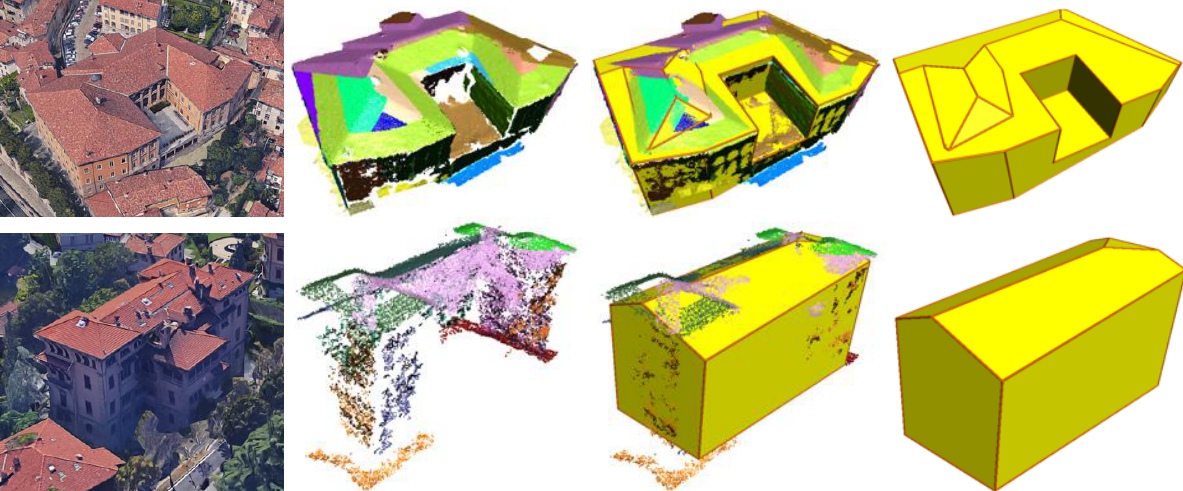
Figure 13. Examples of 3D reconstructions of different buildings from the Bergamo dataset: oblique view, planar areas of the cloud identified with RANSAC, optimized planar faces with geometric model and final 3D geometric model, respectively. Some problems are present in areas where the point density (or noise level) is not allowing a correct plane fitting.